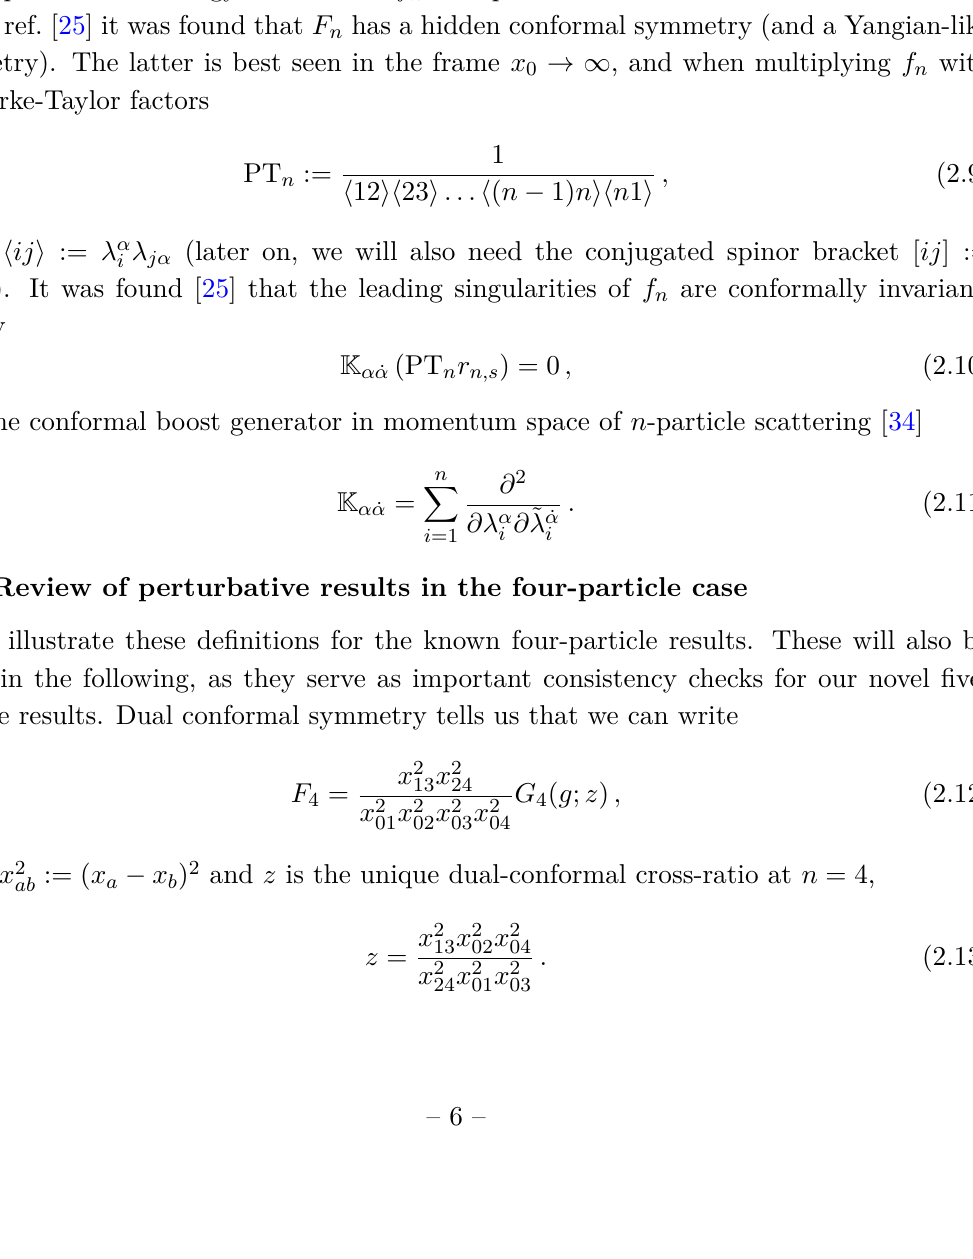
As usual, it is convenient to introduce helicity spinor parametrization of the light-like ˜ momenta, ( p ) ˙ αα ≡ p µ = λ α . Since we have already fixed dual conformal σ ˙ αα λ ˙ α i µ i i i